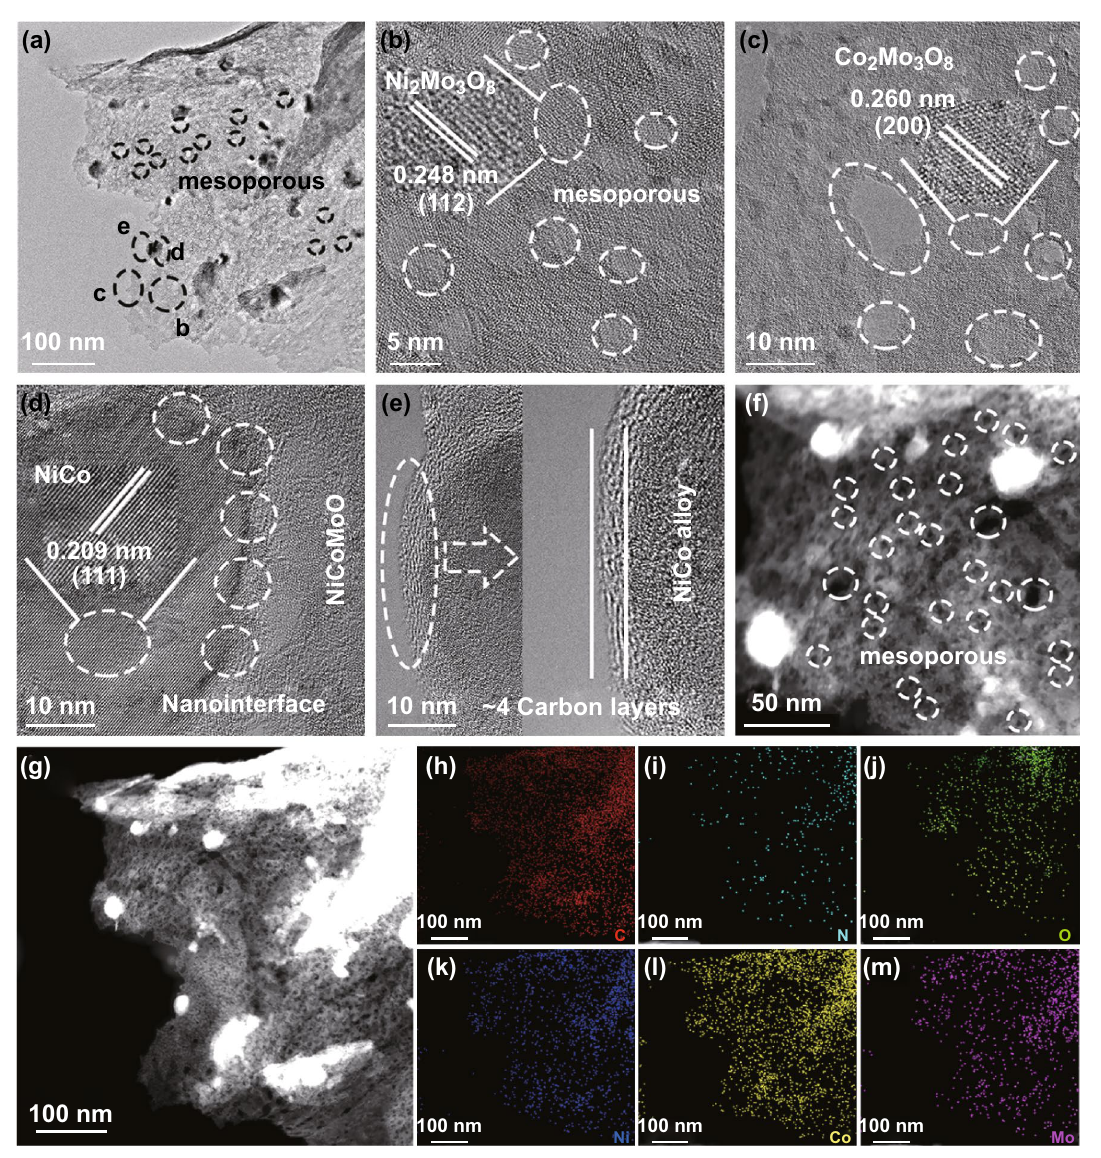
Fig. 2 a – e TEM and HRTEM, f – m HAADF-STEM images and EDS elemental mappings of C, N, O, Ni, Co, and Mo of NiCo@C-NiCoMoO/